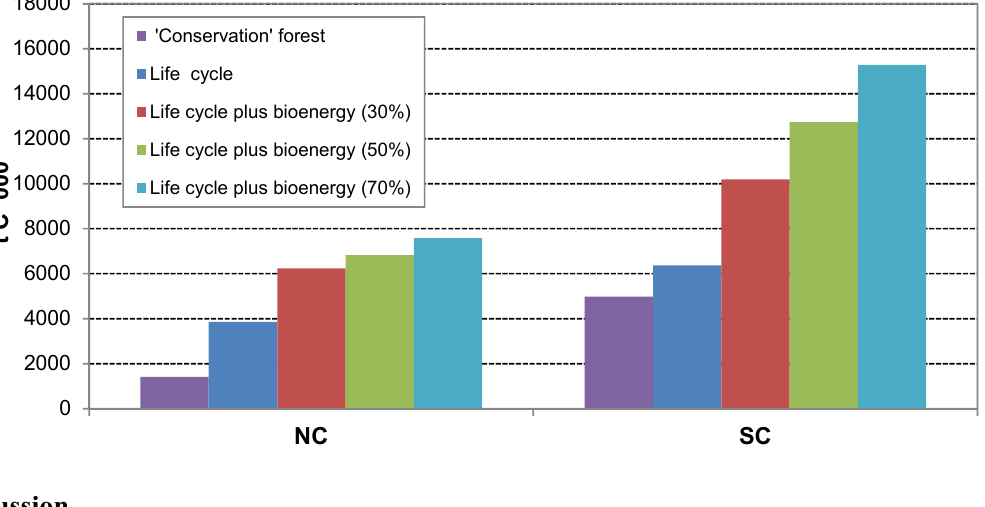
Figure 14. Net greenhouse impact (t C) of Substitution and “life cycle” emissions in the NC and SC simulation. This takes into account a reduction in the temporary C storage in harvest slash residues as a result of extraction of that